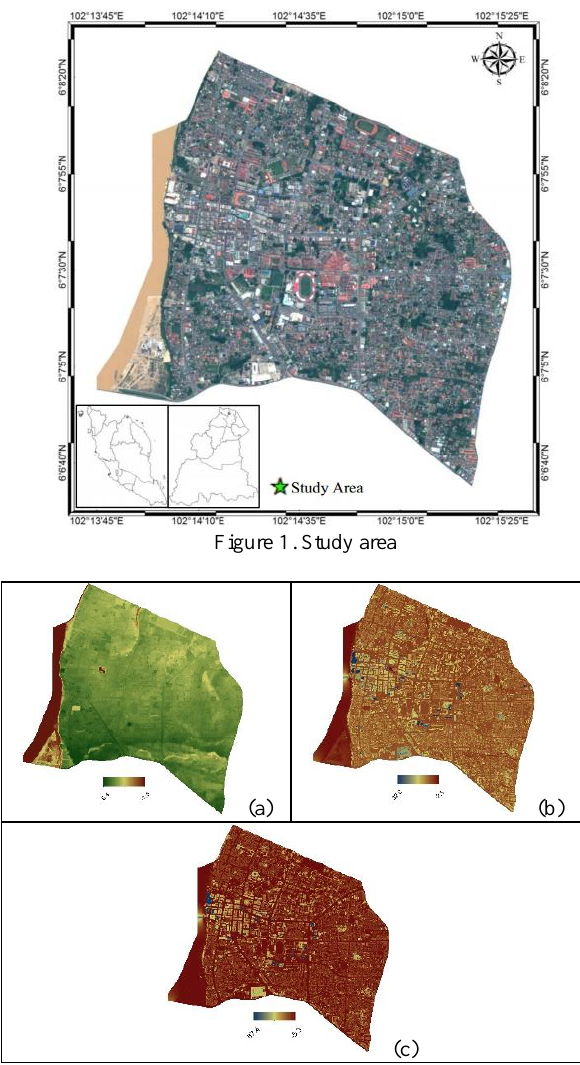
Figure 2 . airborne LiDAR data (a) DTM, (b) DSM, (c) nDSM